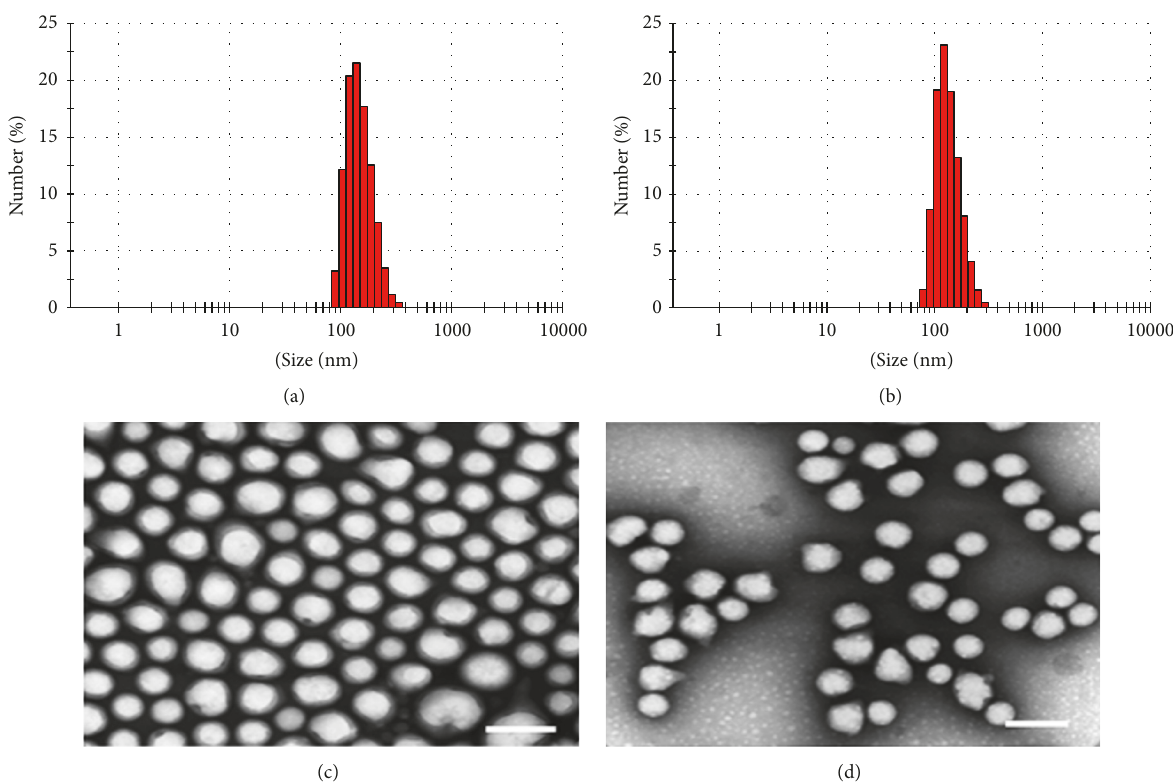
Figure2: Nanoparticlesizedistributionandmorphology .AnarrowsizedistributionofPLGA-PEG P1(a)andPLGA-PEG P3(b)nanoparticles measured by dynamic light scattering is shown. (c) and (d) Transmission electron microscopy (TEM) images show well-dispersed round shaped PLGA-PEG P1 (c) and PLGA-PEG P3 nanoparticles (d). Scale bars = 200 nm.